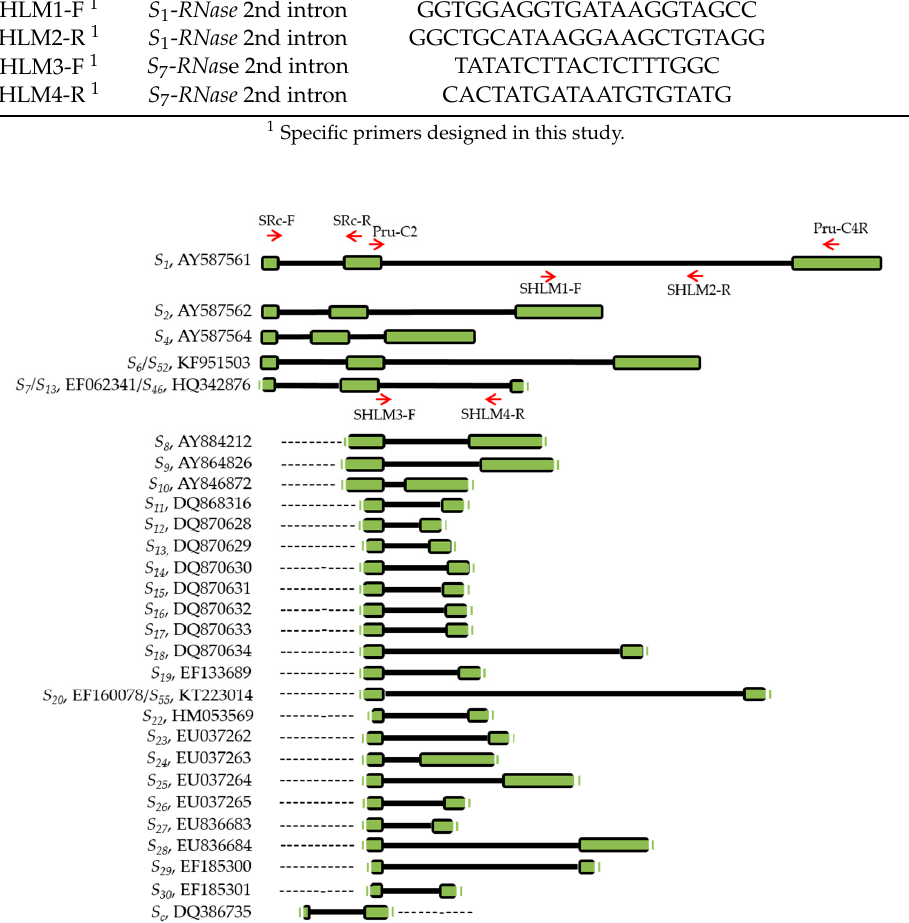
Figure 1. Gene structure of the S -alleles sequenced, showing the exons in green square and including the primers used in this study for the alleles S 1 and S 7 / S 13 / S 46 . Unknown sequences are represented by dotted lines. The first column shows S -genotype and gen bank accession. S 1 [41], S 2 [41], S 3 [41], S 4